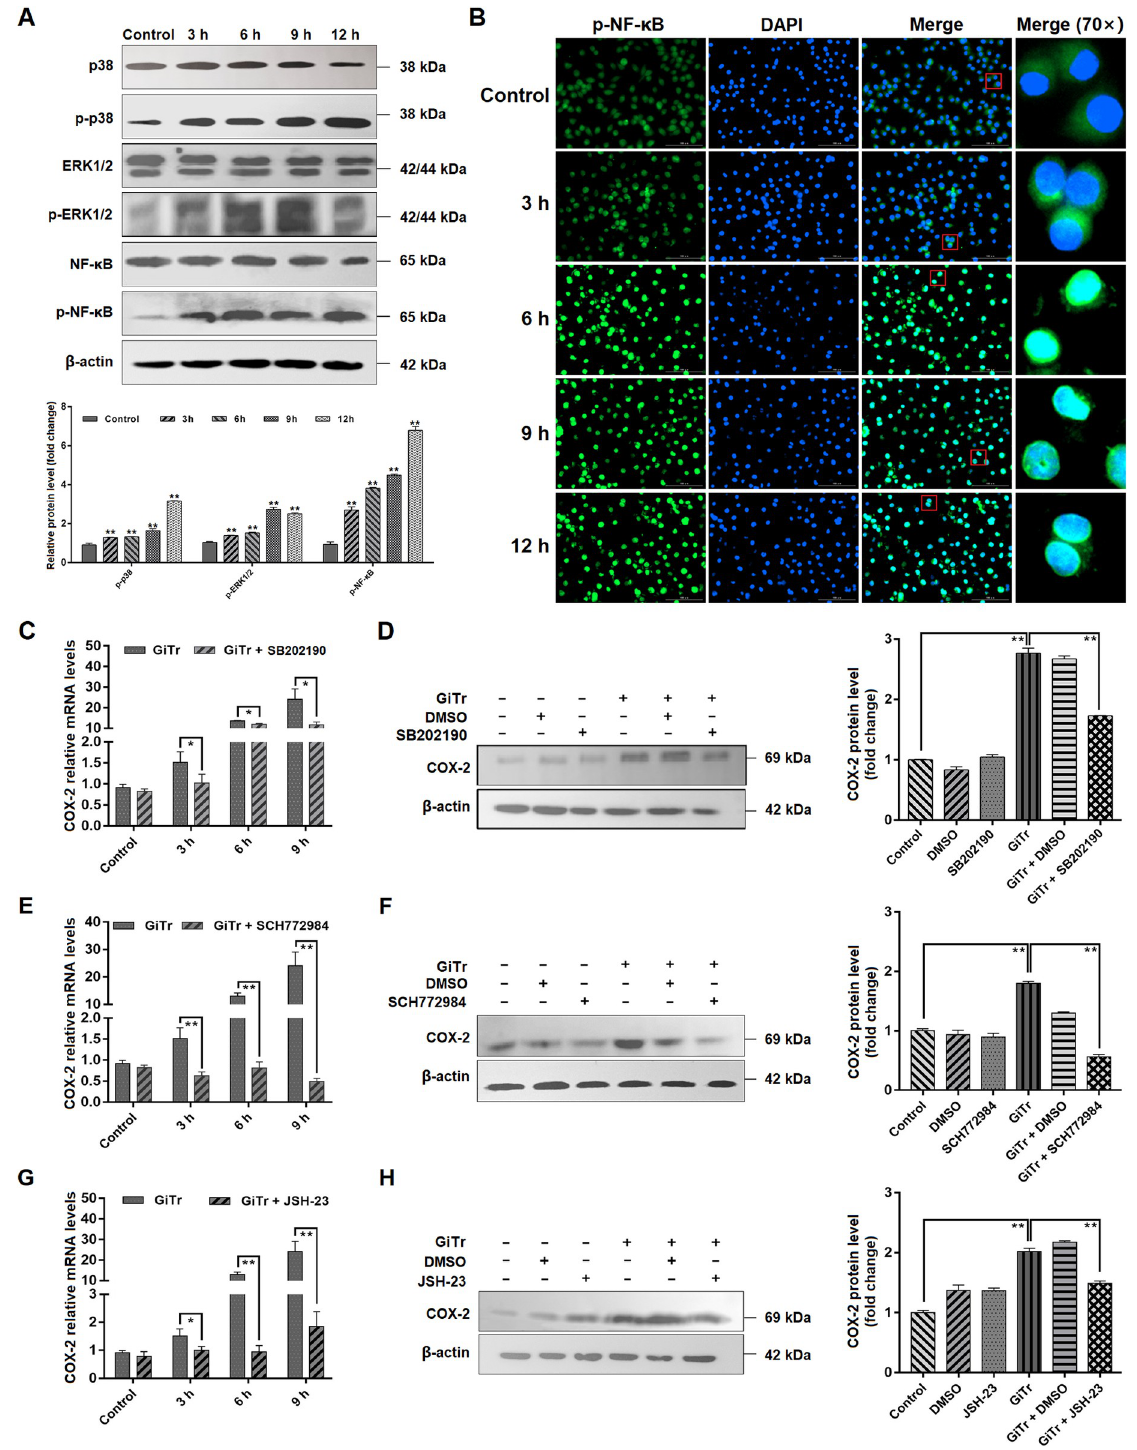
Fig 4. MAPK/NF- κ B signaling regulated COX-2 expression. Unless otherwise specified, J774A.1 cells were challenged with Giardia trophozoites for the indicated time periods. (A) Giardia challenge affected the phosphorylation levels of p38, ERK, and NF- κ B as assessed by western blot and gray value analyses. (B) Giardia exposure affected NF- κ B nuclear translocation as assayed by indirect immunofluorescence staining (scale bar = 100 μ m). (C-H) p38 inhibition by SB202190, ERK inhibition by SCH772984, and NF- κ B inhibition by JSH-23 affected Giardia -induced up-regulation of COX-2. (C,E,G) p38, ERK, or NF- κ B inhibition affected Giardia -induced up-regulated mRNA level of